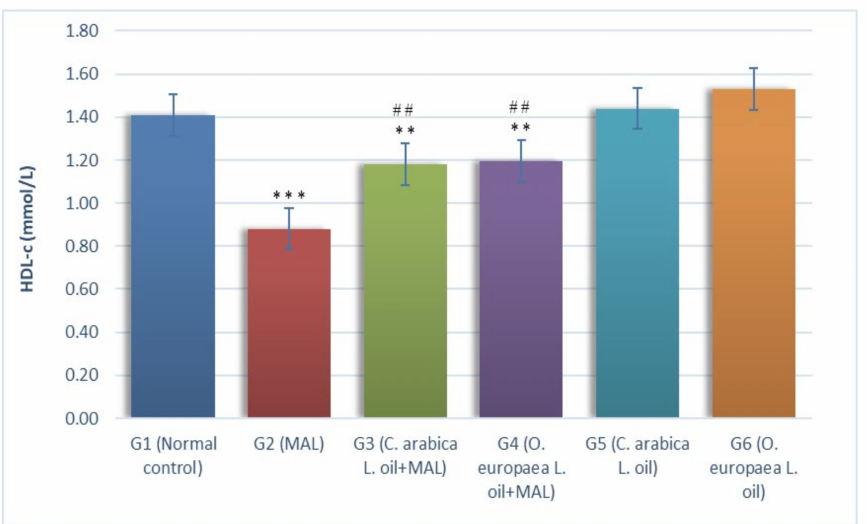
Figure 5. Influence of Coffea arabica L. oil and Olea europaea L. oil on the level HDL-c. When a comparison was made against the normal control group, a significant difference was found in the mean values at p ≤ 0.01 **; p ≤ 0.001 ***. When a comparison was made against the MAL-intoxicated rats, a significant difference was found in the mean values at p ≤ 0.01 ##